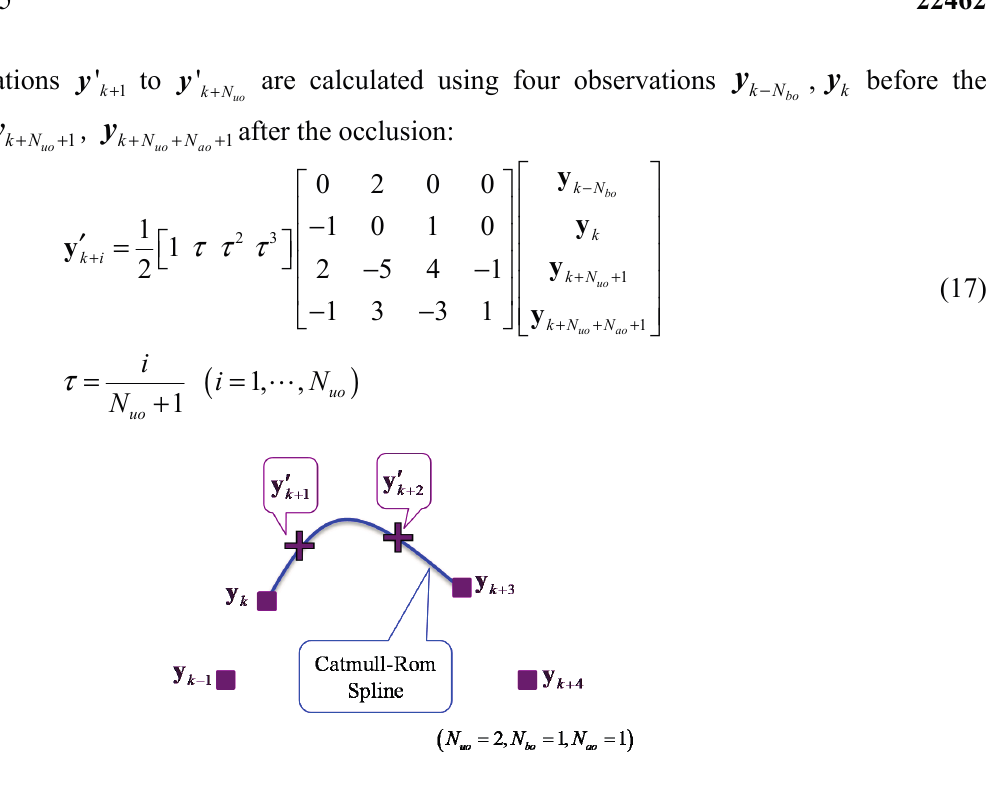
Figure 9. Vertical observations during the occlusion are calculated by the Catmull–Rom